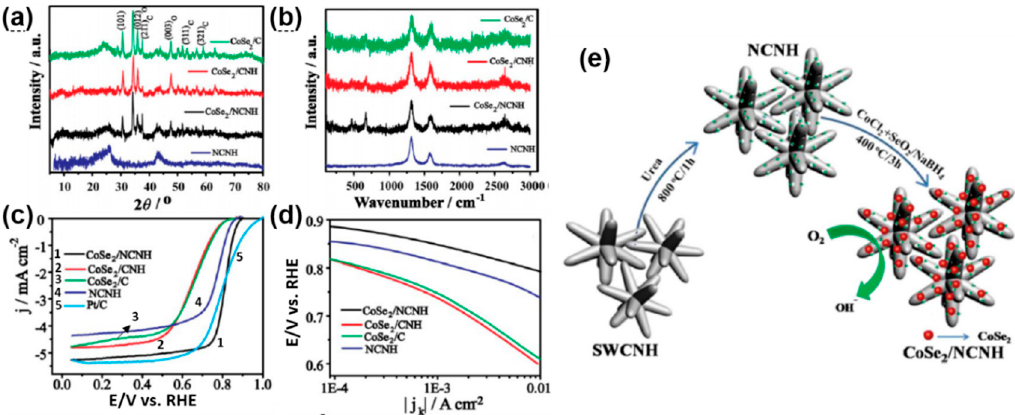
Figure 3. ( a ) Raman spectra; ( b ) X-ray diffraction (XRD) patterns; ( c ) oxygen reduction reaction (ORR)